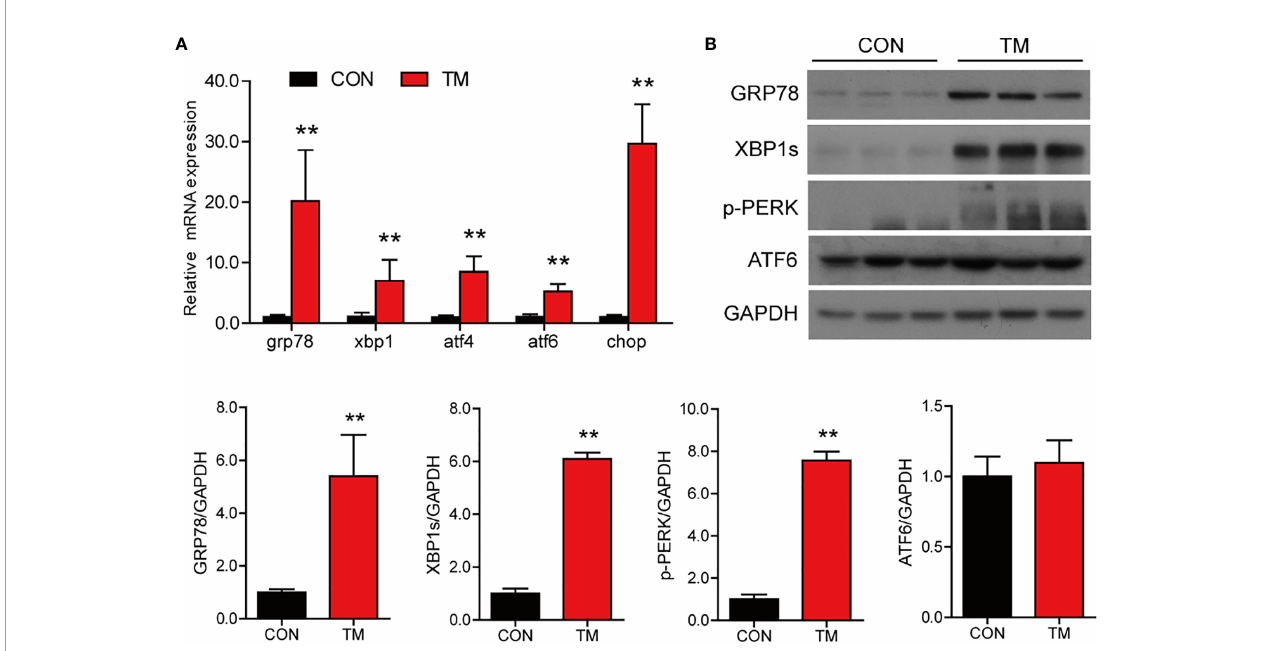
FIGURE 1 | TM injection induces ER stress in the intestine of large yellow croaker in vivo . (A) Relative mRNA expression of ER stress-related genes in the intestine of large yellow croaker after TM injection for 24 h (n = 6). (B) Western blot analysis of GRP78, XBP1s, p-PERK, and ATF6 protein levels in the intestine of large yellow croaker after TM injection for 24 h (normalized to GAPDH, n = 3). grp78 , glucose related protein 78; xbp1 , X-box binding protein 1; atf4 , activating transcription factor 4; atf6 , activating transcription factor 6; chop , C/EBP homologous protein; PERK, double-stranded RNA-dependent protein kinase-like ER kinase; GAPDH, glyceraldehyde-3-phosphate dehydrogenase. Results were analyzed using independent t -test (** P < 0.01), and they were presented as mean ± standard